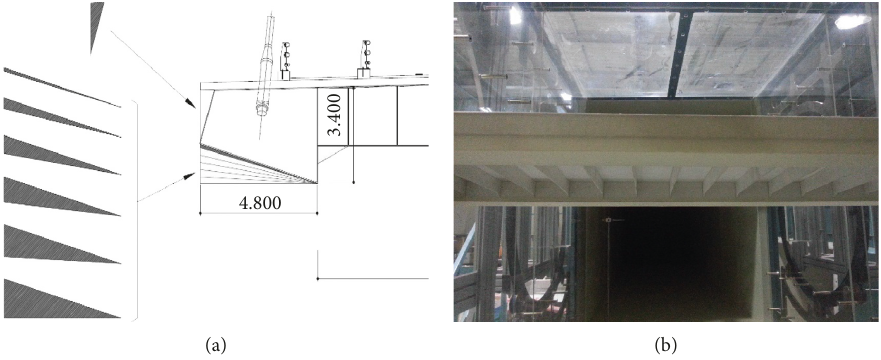
Figure 6: Box slope variation: (a) slope variation with various attachment brackets; (b) test section with 9 ° slope.